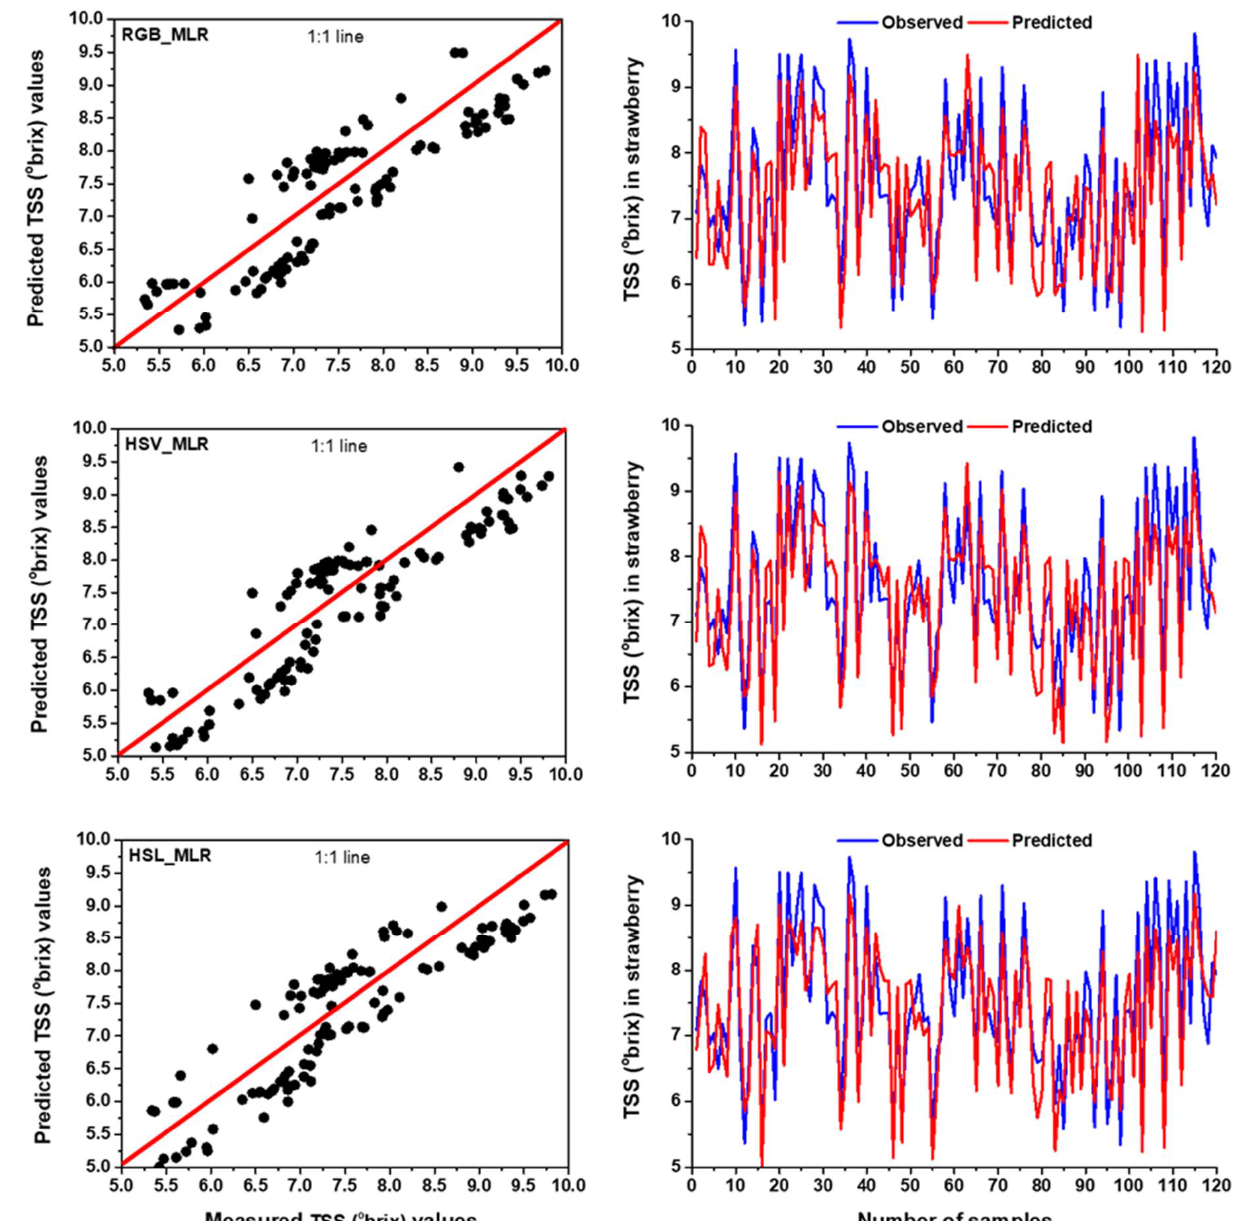
Figure 6. The comparison results between measured and predicted values by MLR model with RGB, HSV and HSL colour spaces for TSS prediction in the testing period using time series and scatter plots with 1:1 line.